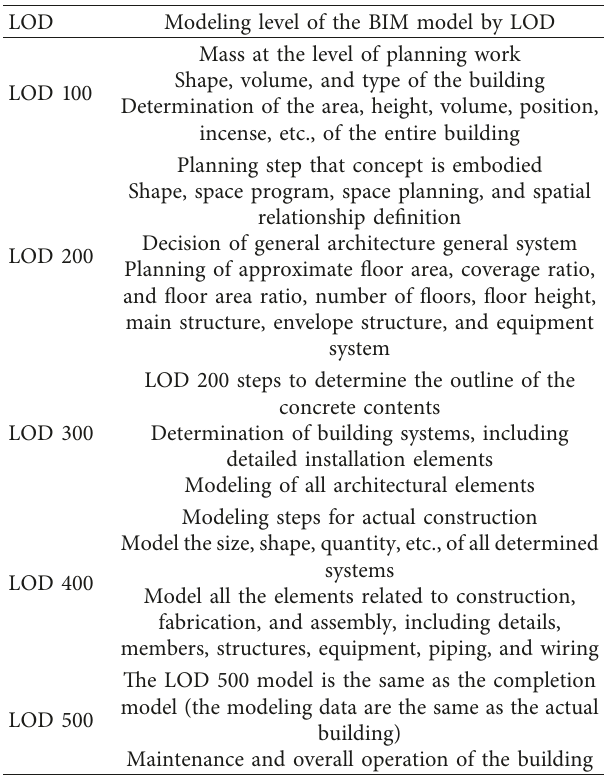
Table 1: LOD step